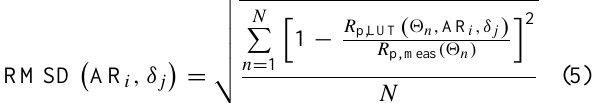
as a function of aspect ratio and roughness parameter. Here, µ p = 1 . 5 and λ p = 100cm − 1 (Heymsfield et al., 2002),